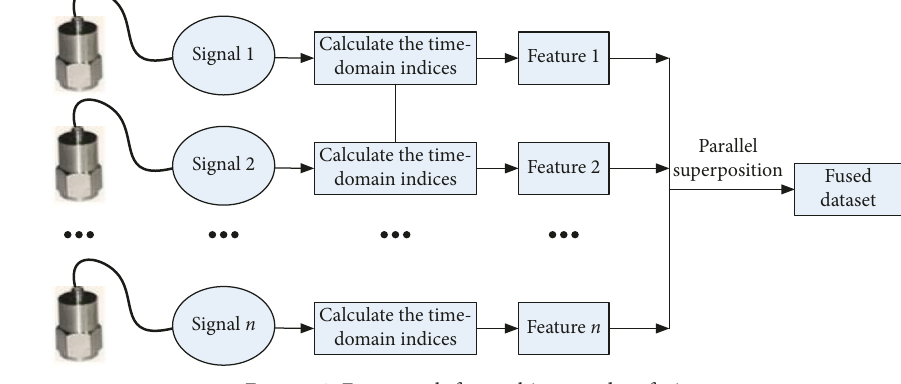
Figure 4: Framework for multisensor data fusion.